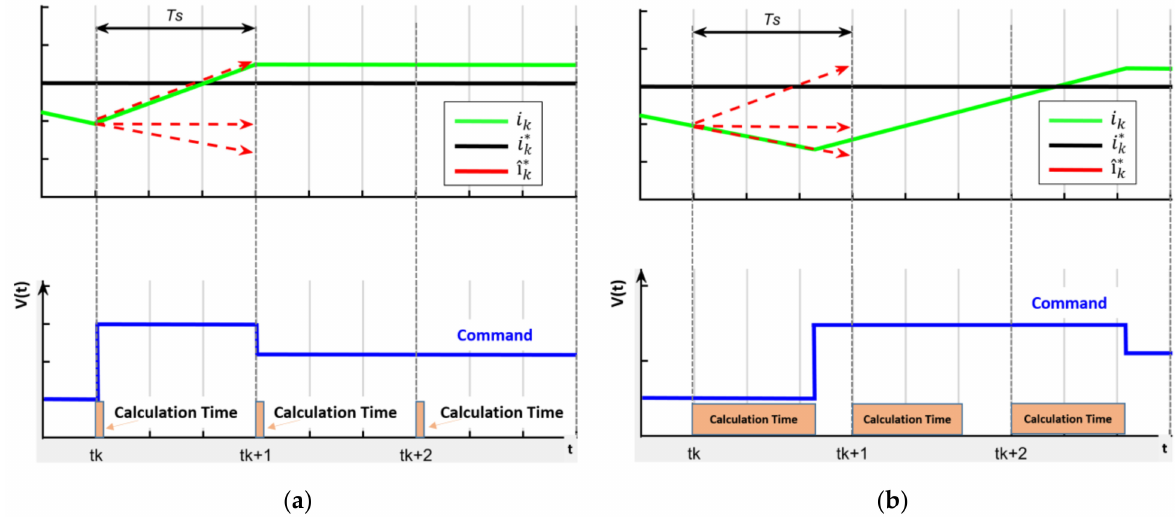
Figure 7. Predictive control operation, ( a ) ideal case: calculation time is negligible, ( b ) practical case: calculation time is